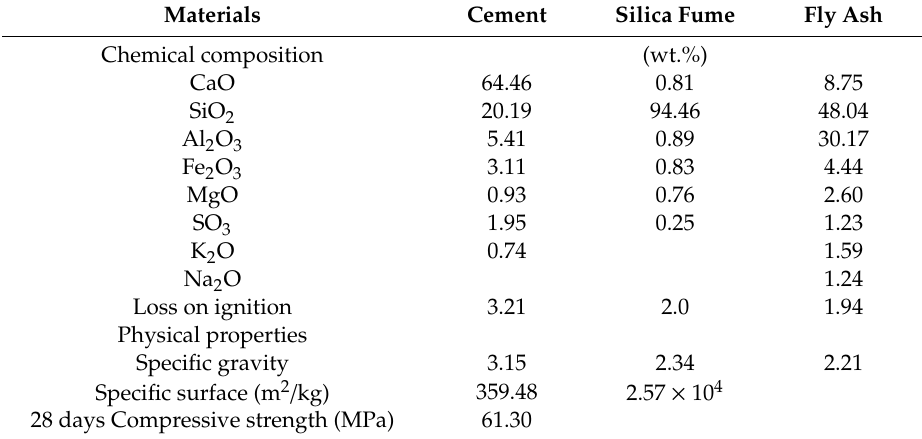
Chemical composition and physical properties of cement and supplementary cementitious